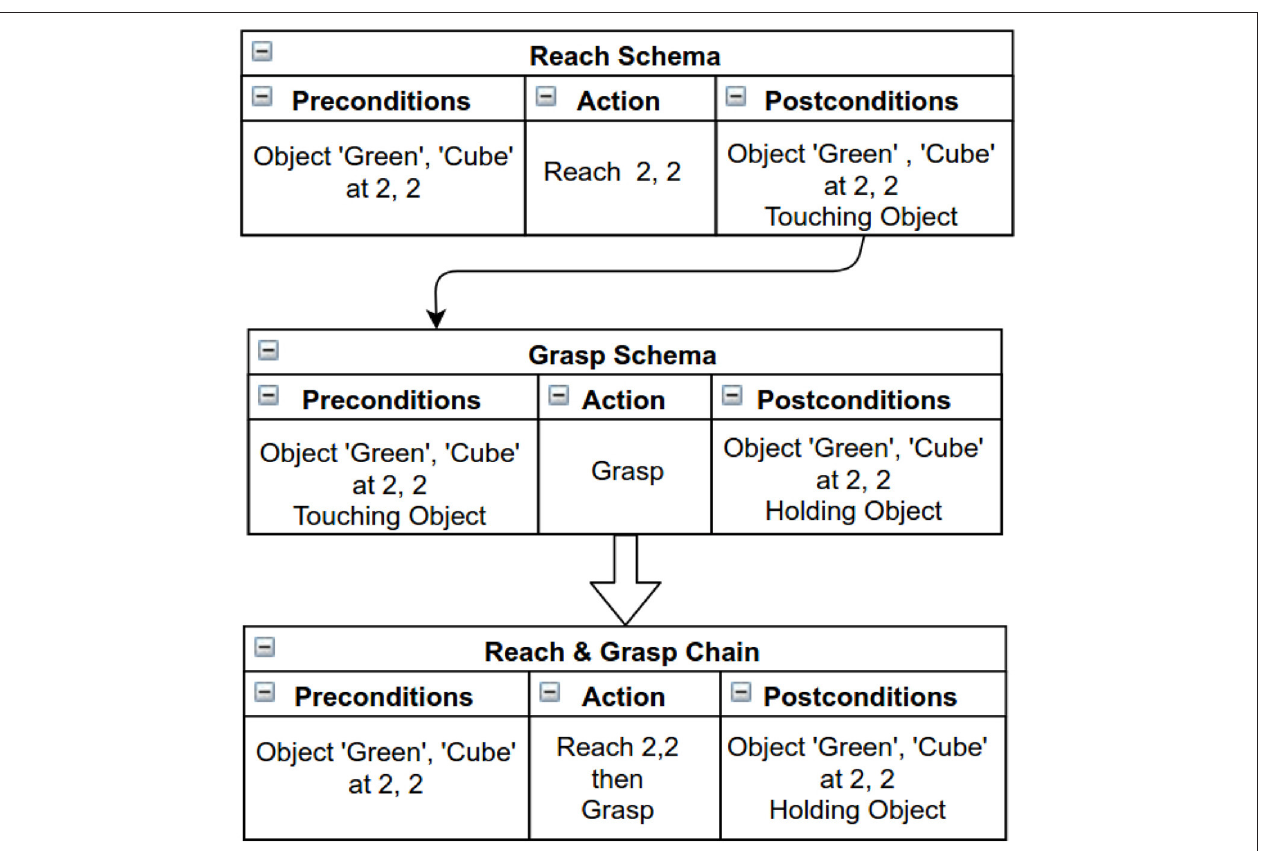
FIGURE 3 | An example of chaining. Two schemas are combined to create a “2-Schema chain”.